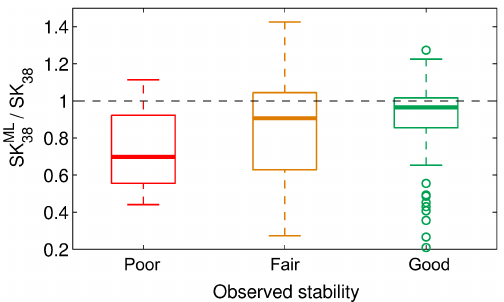
Figure 6. (a) The skier stability index SK ML without a skier ( ψ = 38 ◦ , R = 500Nm − 1 , ρ = 200kgm − 3 , τ different ratios of the slab and weak-layer moduli (according to Eq. 11).